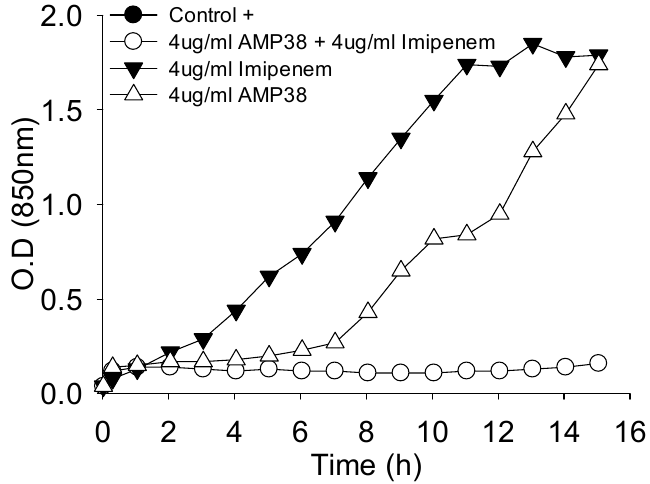
Figure 3. Growth inhibition by the combination of imipenem and AMP38 at 4 μ g/mL of each.